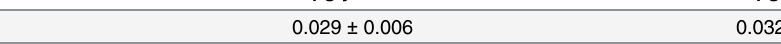
Table 1. Kinetic parameters for the activation of Sf β gly-N and Sf β gly-C. Sf β gly-N Sf β gly-C k (h -1 ) 0.029 ± 0.006 0.032 ± 0.007 Rate constants ( k ) for the activation process were calculated based on seven independent